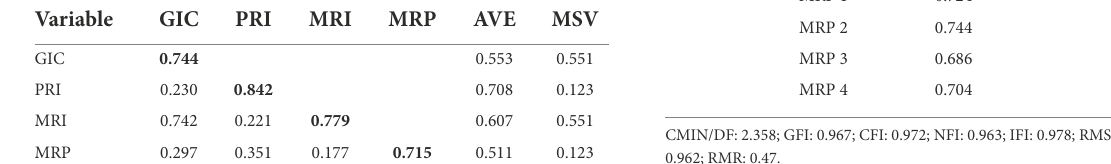
TABLE 2 Descriptive statistics and correlations.